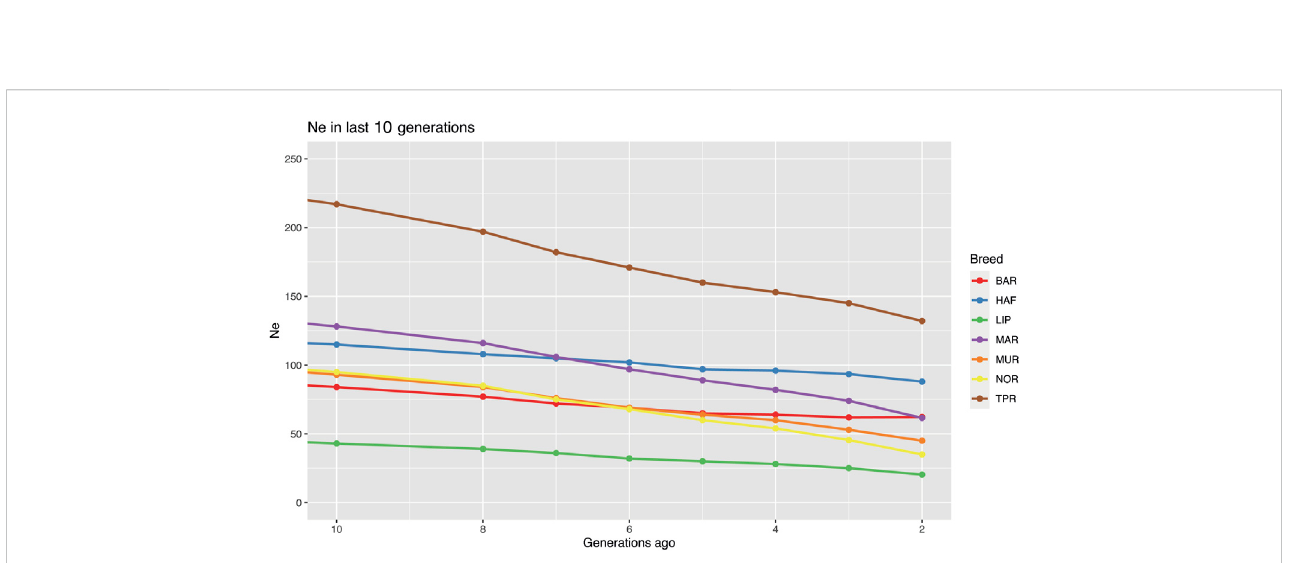
FIGURE 6 Effective population size estimation in seven Italian breeds (Bardigiano, BAR; Ha fl inger HAF; Lipizzaner, LIP; Maremmano, MAR; Murgese, MUR; Noriker, NOR; Cavallo Agricolo Italiano da Tiro Pesante Rapido, TPR) according to SNeP. Only last 10 generations are shown. Figure showing full analysis in the last 1,000 generations is available in Supplementary Figure